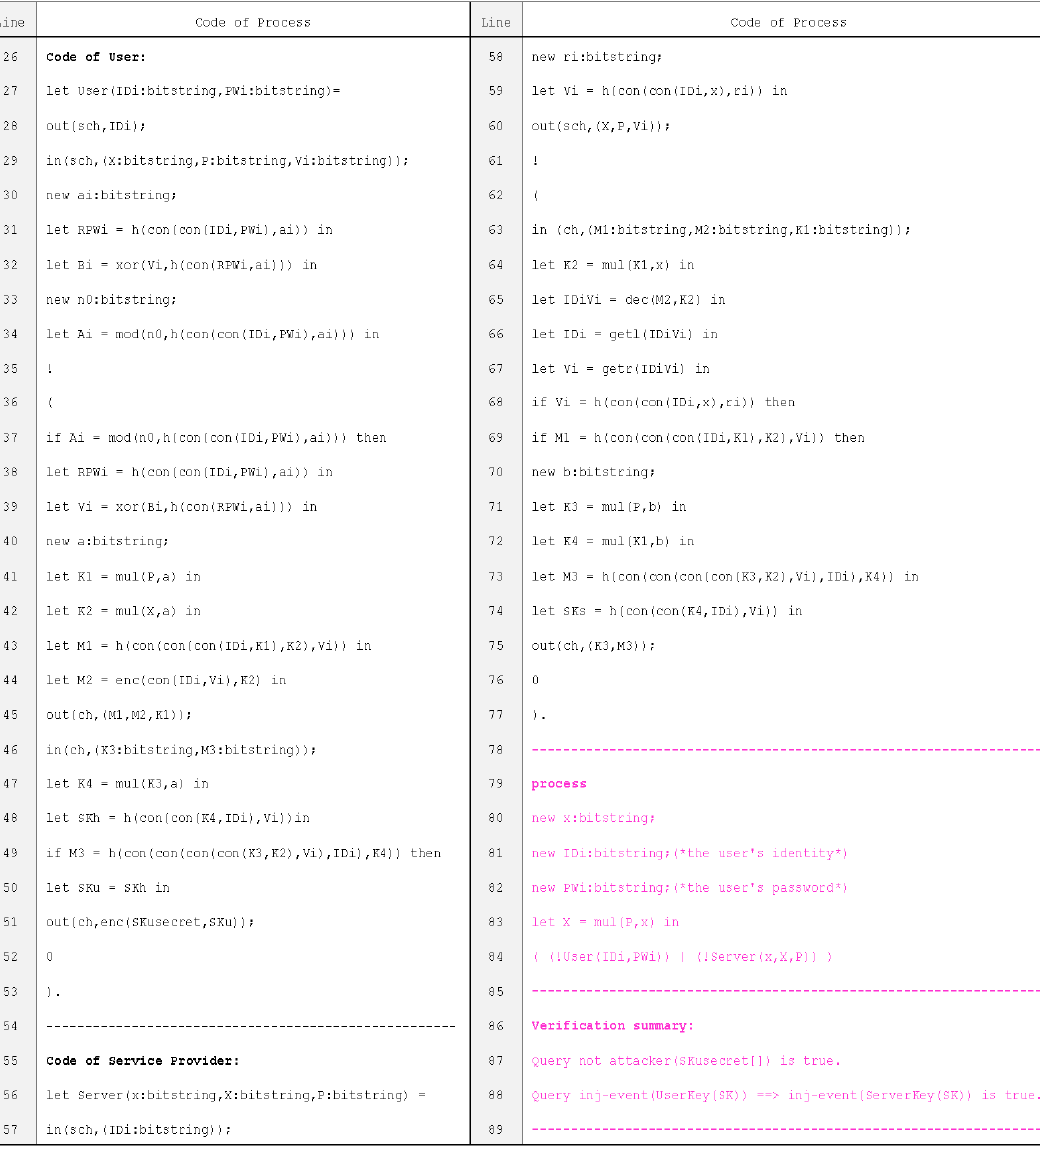
Figure 3. Code for process in ProVerif.